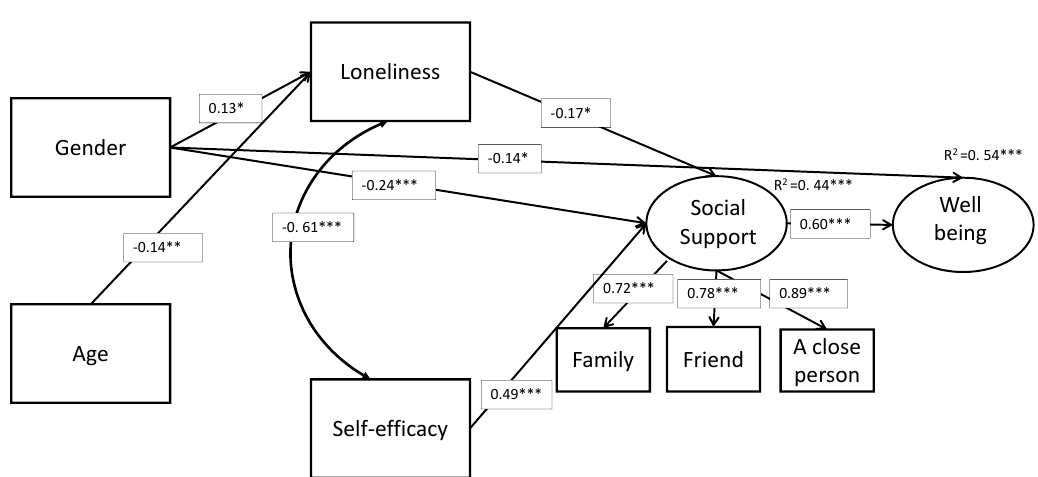
Figure 3. The model within a structural equation framework for learning disability (LD) group. *** p < 0.001; ** p < 0.01; * p <